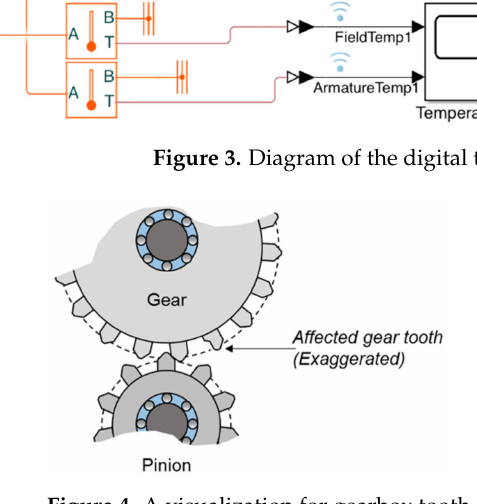
Figure 4. A visualization for gearbox tooth faults